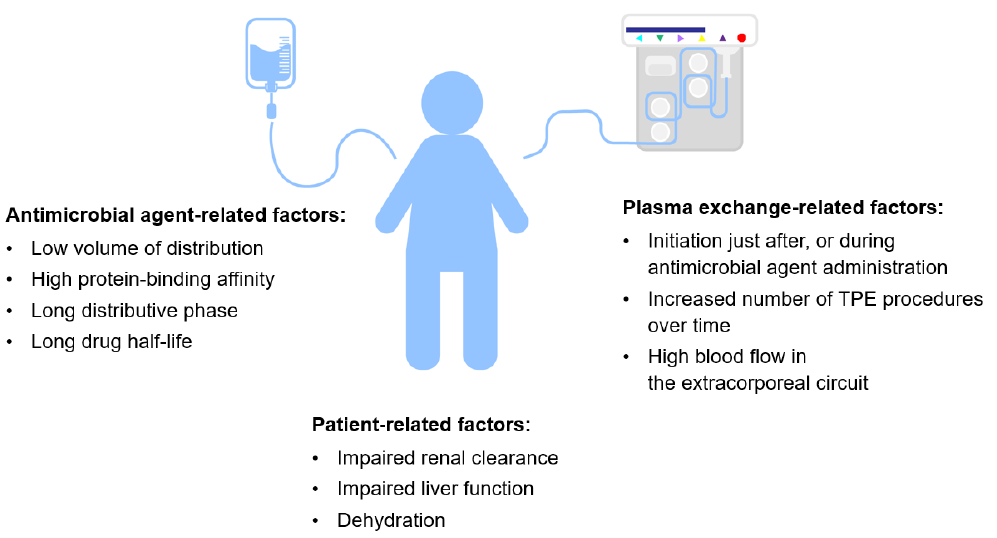
Figure 4. Possible factors accounting for reduction of antimicrobial treatment efficacy.